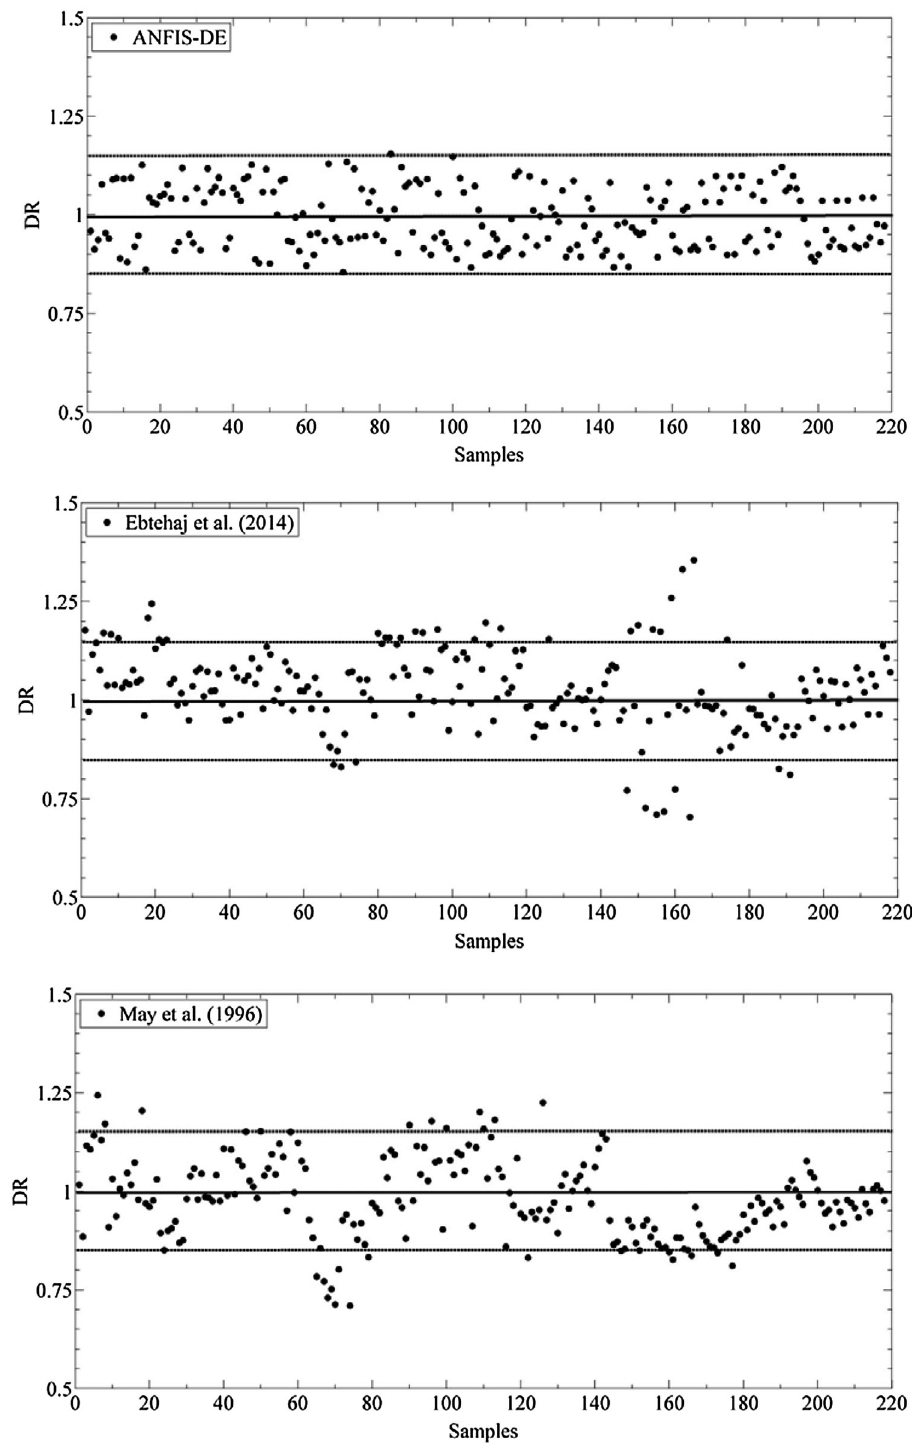
Fig. 5 DR values for